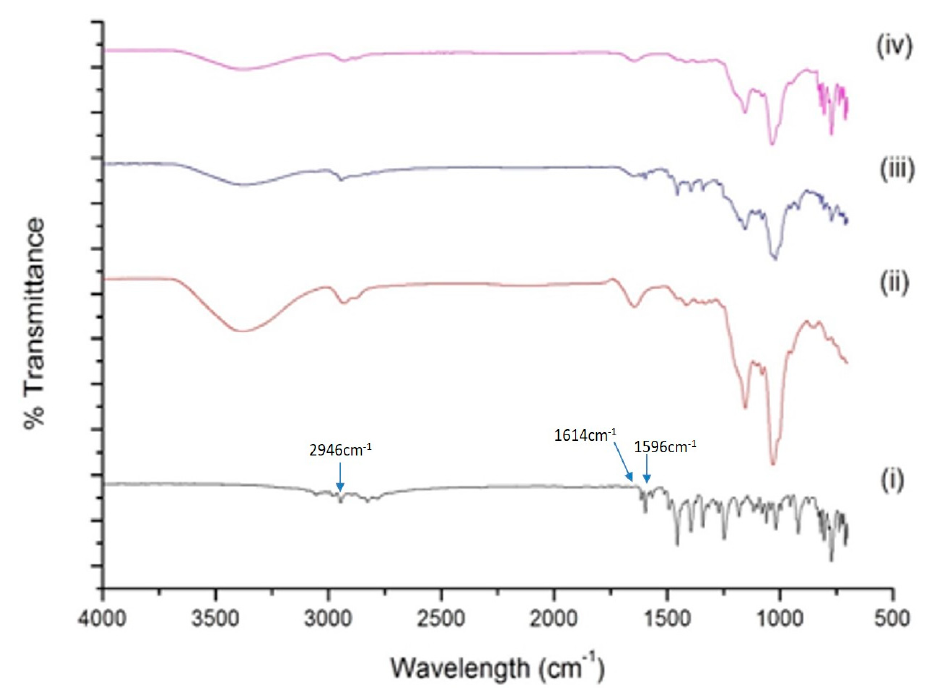
Figure 3. FT-IR spectra of bedaquiline (i), SBE- β -CD (ii), the physical mixture of bedaquiline and SBE- β -CD (iii), and the inclusion complex BDQ-CD (iv).